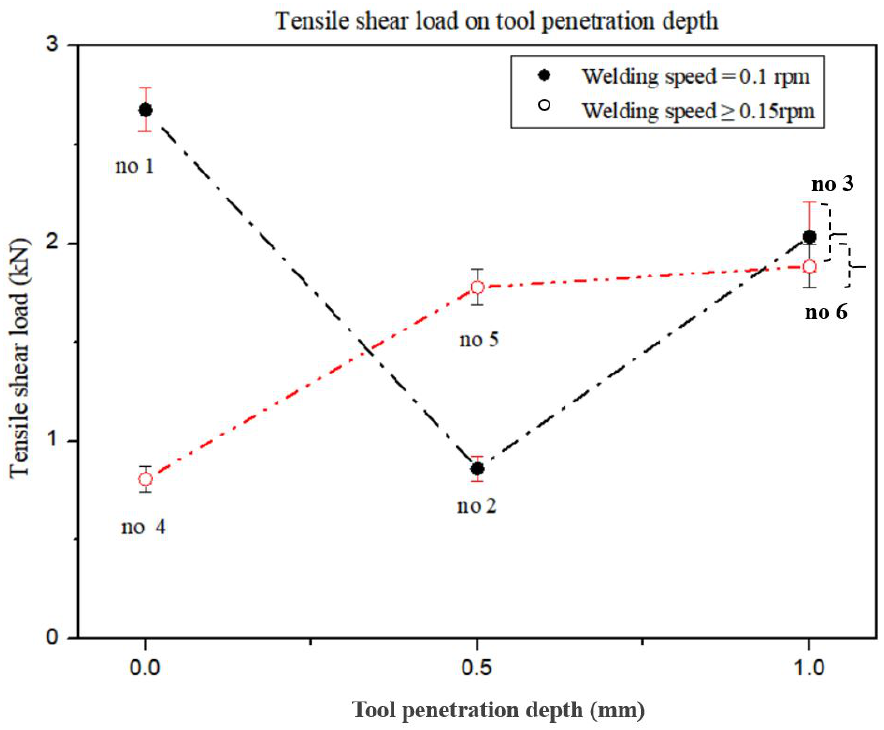
Figure 7. Comparison of TSL with TPD for experiment groups A and B [16].